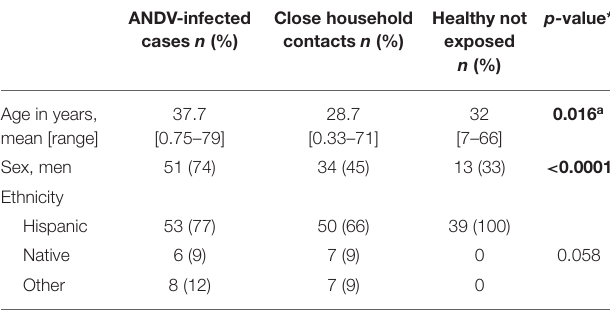
TABLE 1 | Demographic description of 69 cases, 76 close household contacts and 39 healthy controls not exposed. ANDV-infected cases n